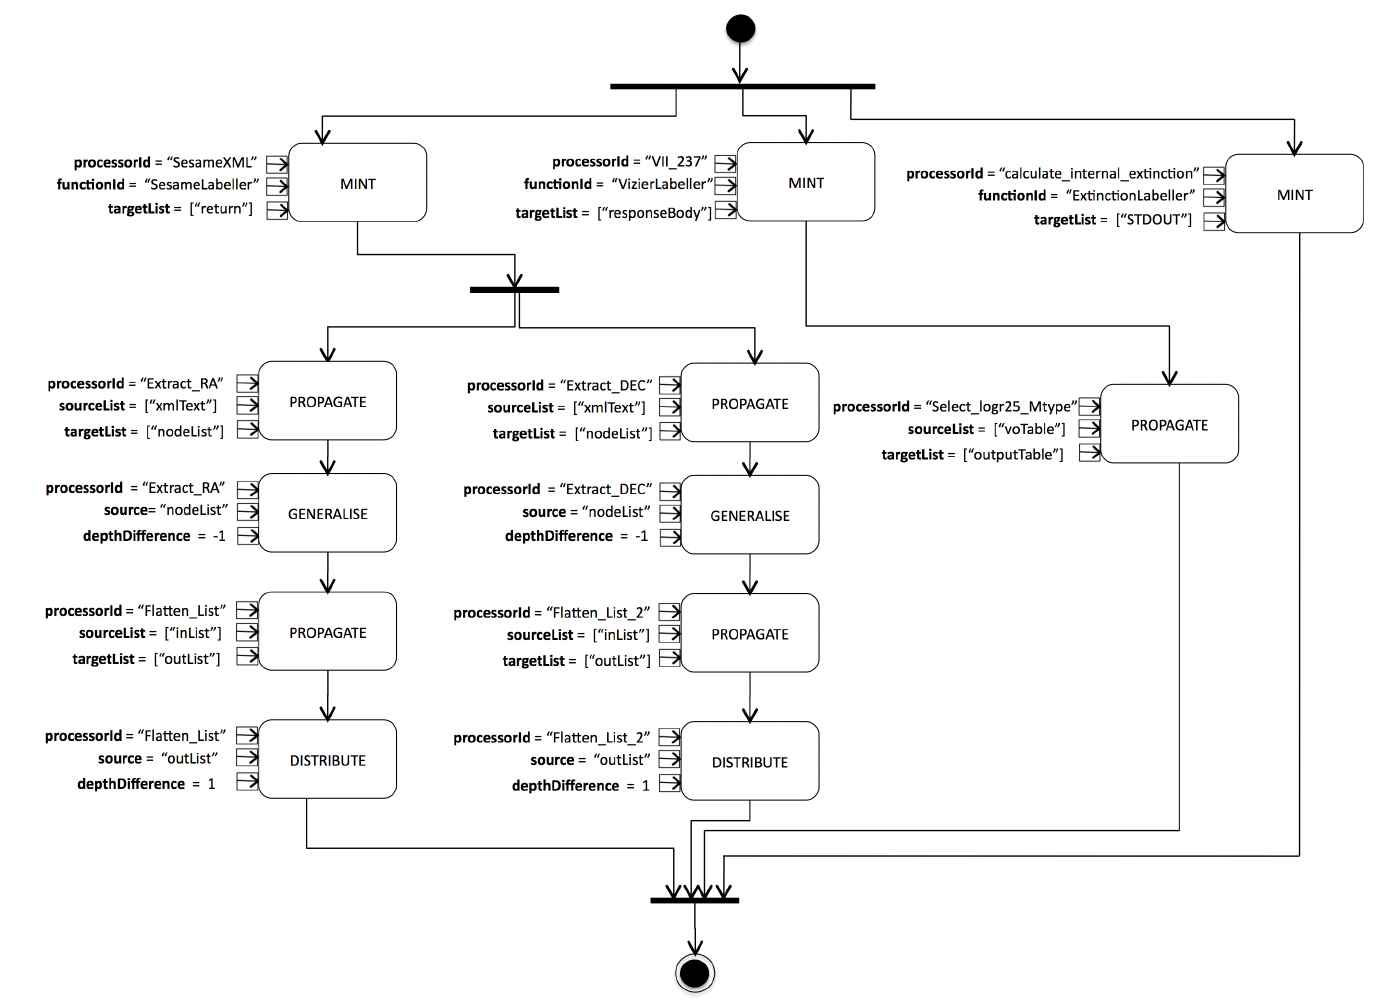
Figure 13. The labelling pipeline for the case-study